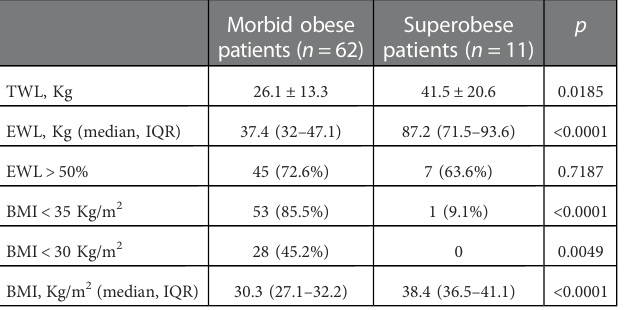
TABLE 5 Comparison of outcomes at 24 months of patients that underwent sleeve